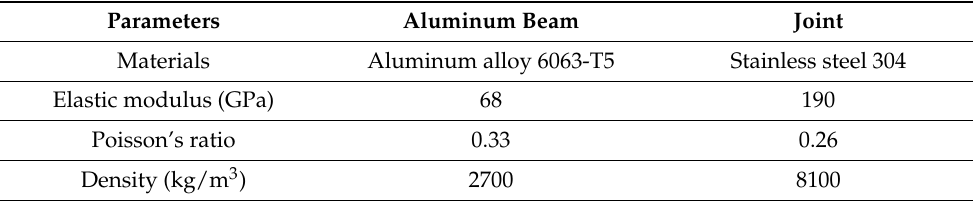
Table 1. Material properties of aluminum beam and joint.